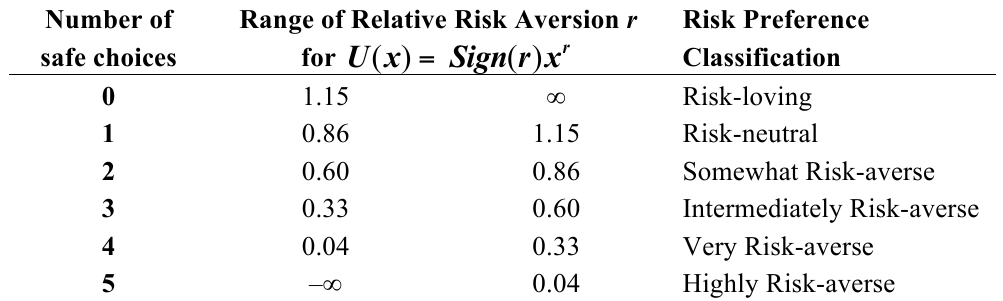
Table 4. Implied ranges of risk aversion